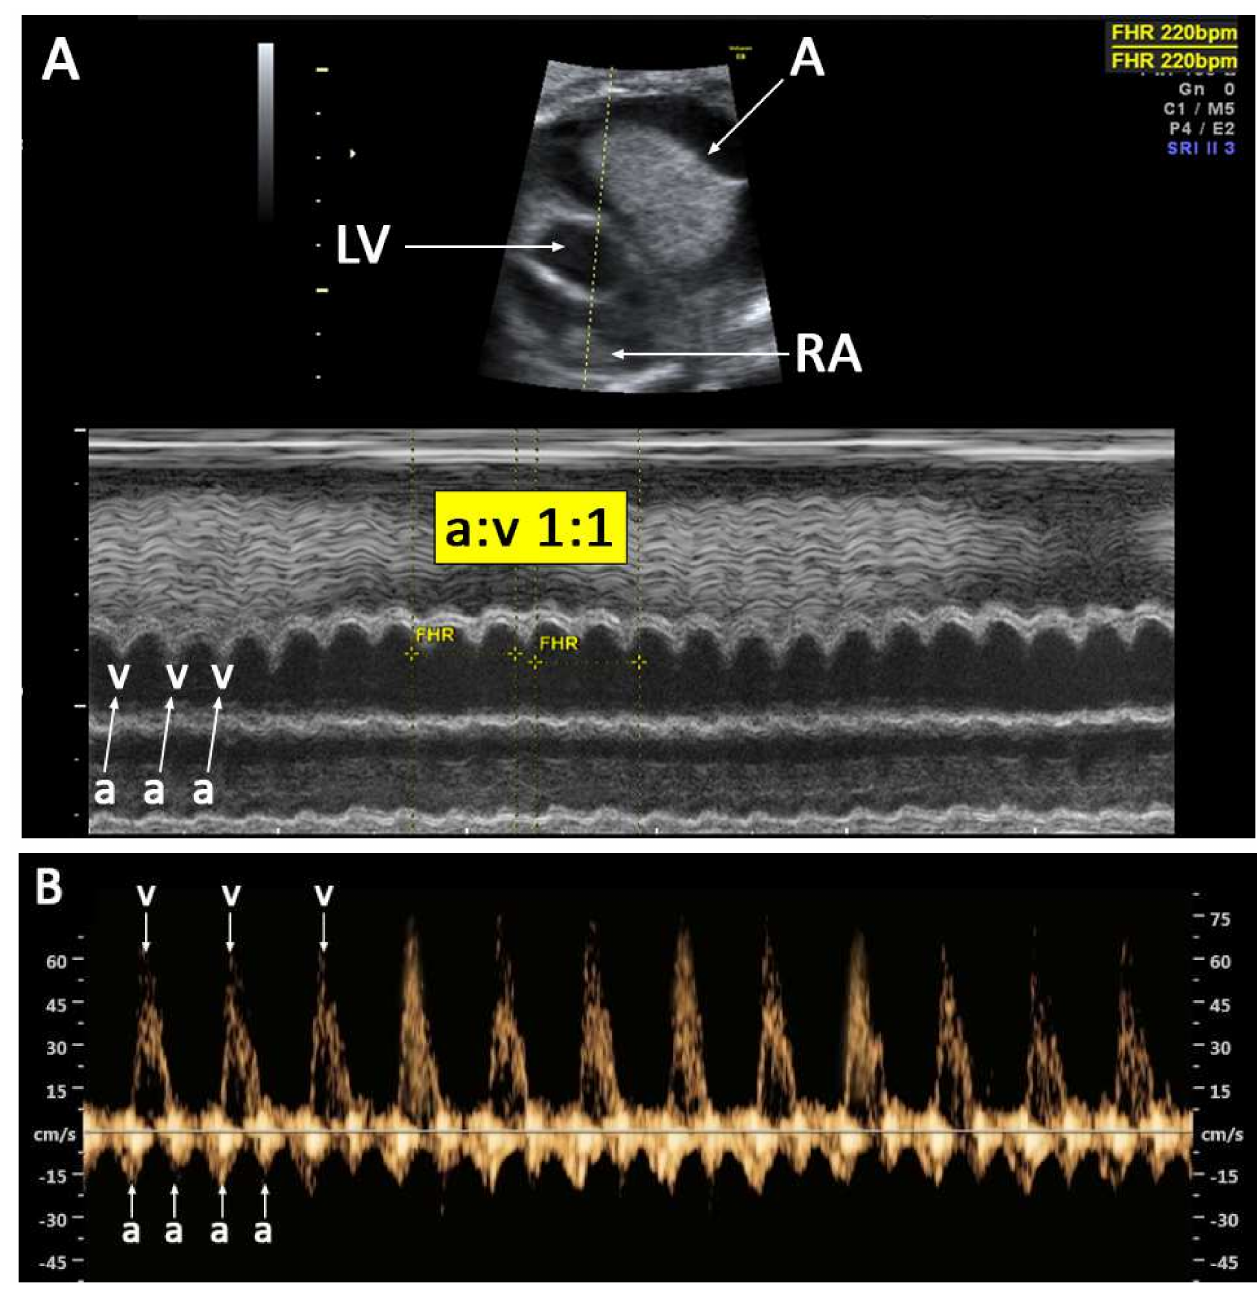
Figure 3. ( A ) M-mode shows supraventricular tachycardia; atrial rate (a): ventricular rate (v) (A): ascites; LA: left atrium; RA: right atrium); ( B ) cardiac Doppler waveforms at left inflow and outflow shows atrial flutter; atrial rate (a): ventricular rate (v) 2:1 (440:226). A summary of the characteristics of the three cases with AF associated with ASA is presented in Table